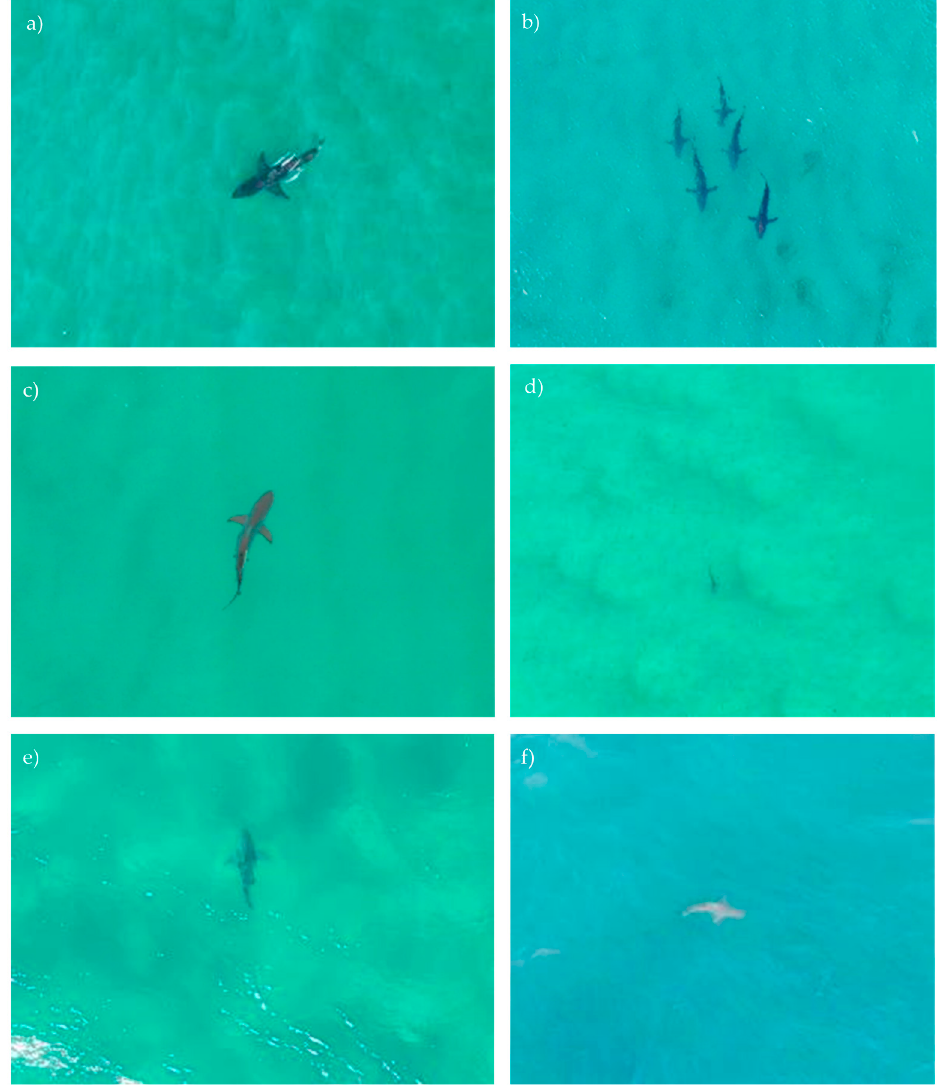
Figure 3. Example images of sharks recorded during the Queensland SharkSmart drone trial. ( a ) white shark ( Carcharodon carcharias ), recorded at Southport Main Beach, Gold Coast in September 2020, ( b ) group of five large whaler sharks observed at Ocean Beach, North Stradbroke Island in November 2020, ( c ) whaler shark ( Carcharhinus sp.) from the blacktip complex recorded at North Stradbroke Island in December 2020, ( d ) small whaler shark ( Carcharhinus sp.) seen at North Strad- broke Island in January 2021, ( e ) bull shark ( Carcharhinus leucas ) recorded at Burleigh Beach in June 2021 and ( f ) whaler shark ( Carcharhinus sp . ) at North Stradbroke Island in December 2020.